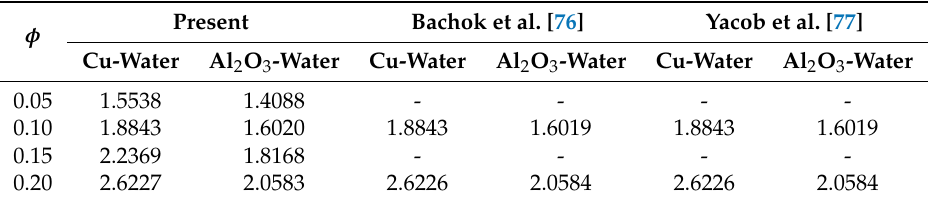
Table 7. Re 1/2 x C f when λ = Z = d = 0, and Pr = 6.2 for various nanofluids.